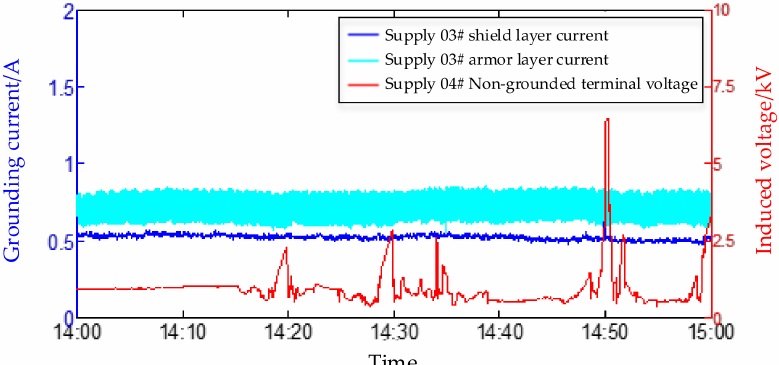
Figure 13. The grounding current and induced voltage at the ungrounded end of the feeder cable of “Hukun 2”.